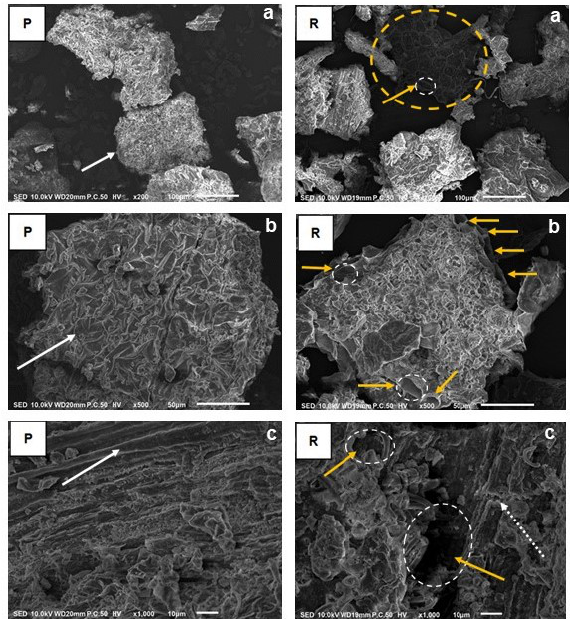
Fig. 3. SEM result of untreated PBL leaves powder (P) and residue of PBL leaves powder after PHWE in optimum condition (R) at x200 (a), x500 (b), and x1,000 magnification (c),